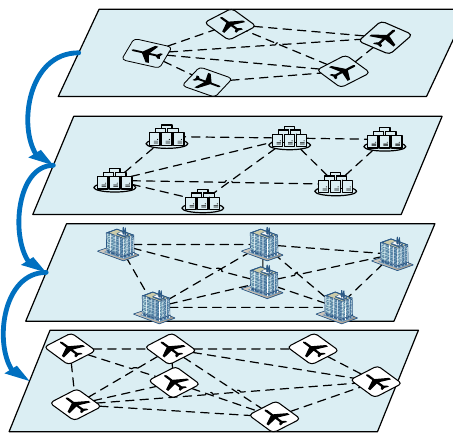
Figure 4. Command post system.